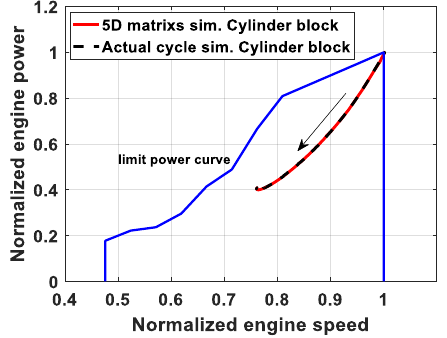
Figure 20. Ship deceleration in the engine map.